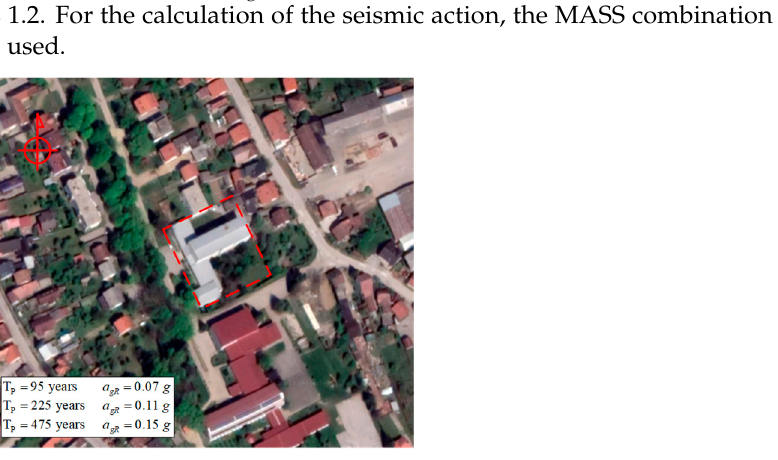
Figure 10. Horizontal peak ground accelerations for soil class A at the location [Google maps].